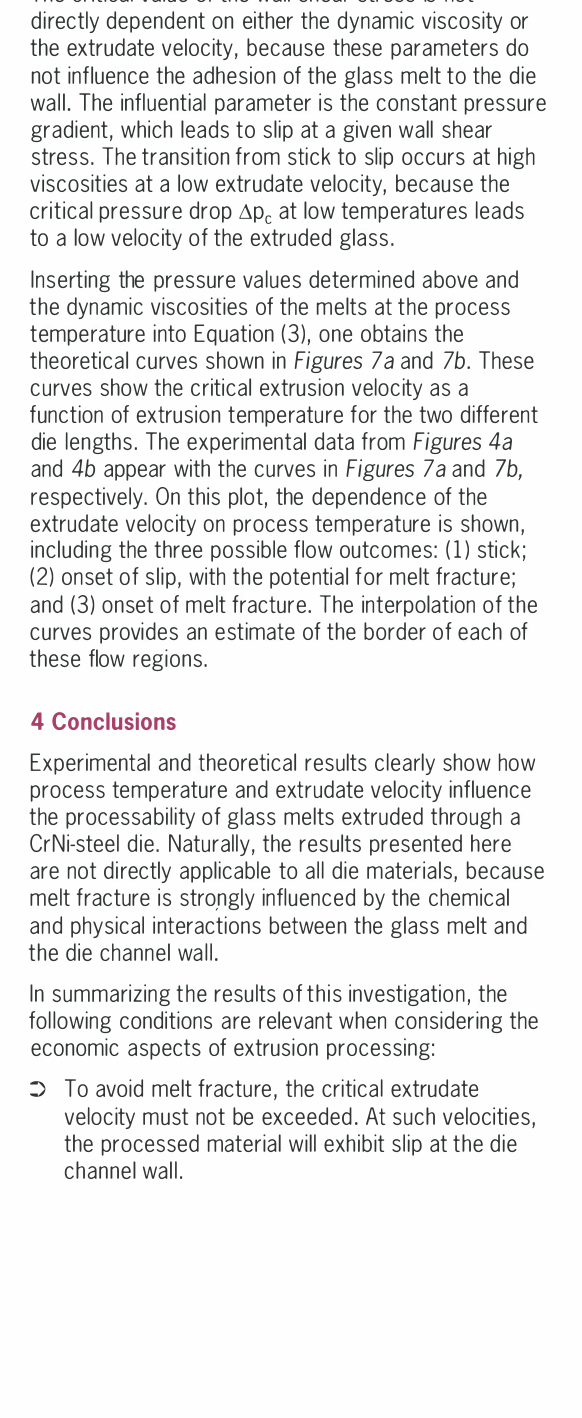
Fig. 7: Extrusion velocities leading to wall slip and melt fracture for (a) 5 mm and (b) 7 mm long CrNi-steel dies as a function of extrusion temperature (D = 5.5 mm; D - measured values; - · -calculated from Equation